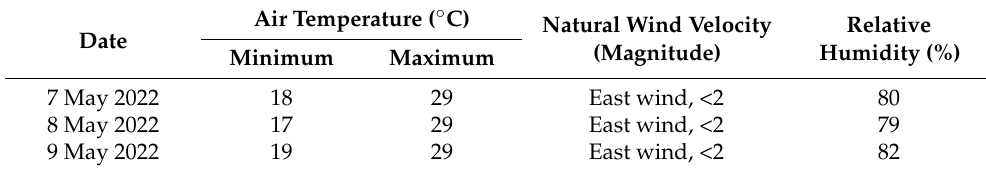
Table 1. Weather conditions during spraying.